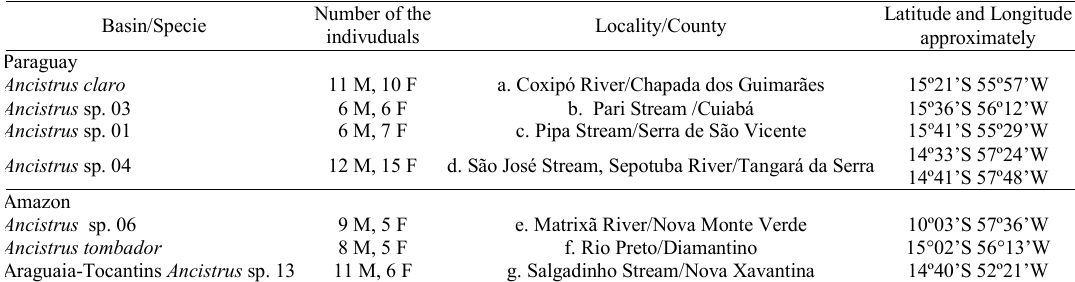
Table 1. Analyzed Ancistrus species with their respective hydrographic basins and locality. M: males, F: females.